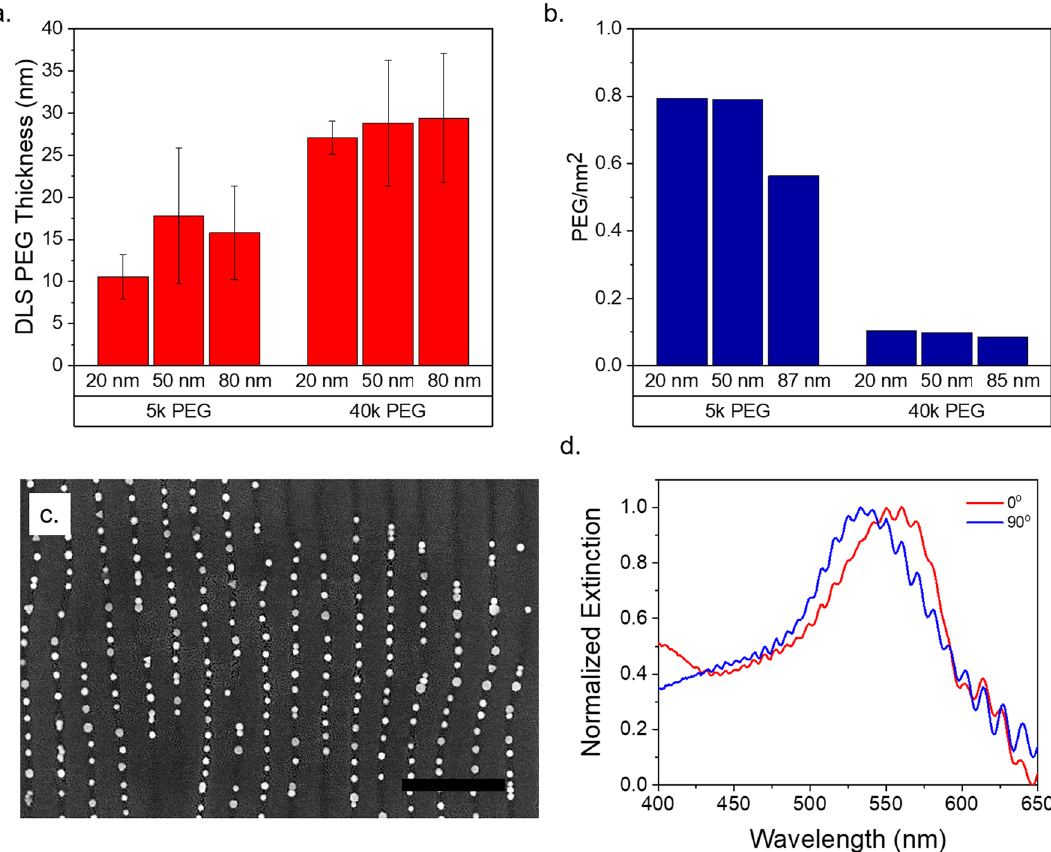
Figure 5. DLS and TGA measurements of PEG-coated AuNPs, SEM image of aligned 20 nm AuNPs on wrinkled graphene, and polarized UV–Vis spectra. PEG hydrodynamic thickness in ethanol on 20–80 nm AuNPs determined by DLS ( a ). PEG grafting density determined by TGA ( b ). SEM ( c ) and UV–Vis spectra ( d ) of 20 nm AuNPs capped with 40k PEG on graphene. Scale bar 500 nm. Error bars are the standard deviation of 3